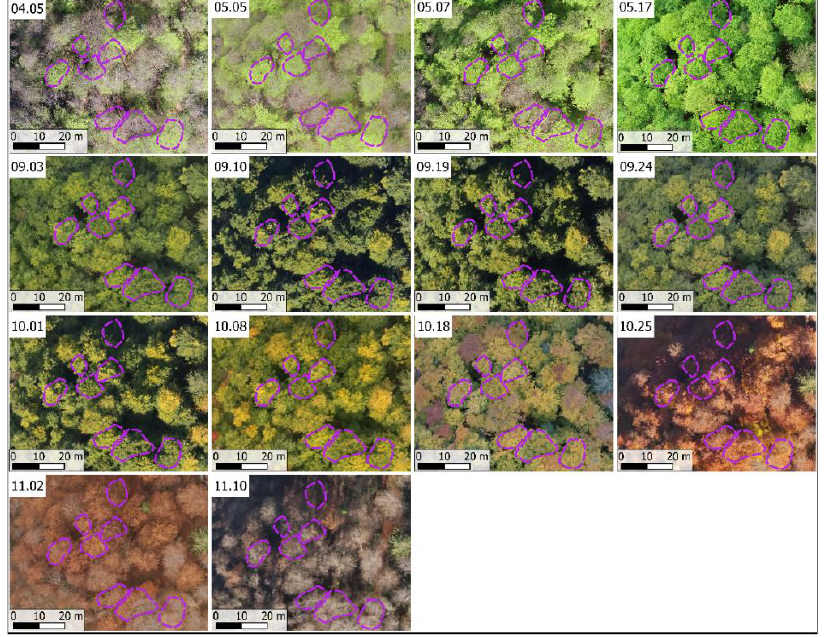
Figure 2. Example of individual sampled beech trees captured at different phenological stages (month and day in the upper left corner of each image) using UAVs during the 2021 growing season. Dashed magenta regions represented crown delineation and were used to retrieve the RGB band length